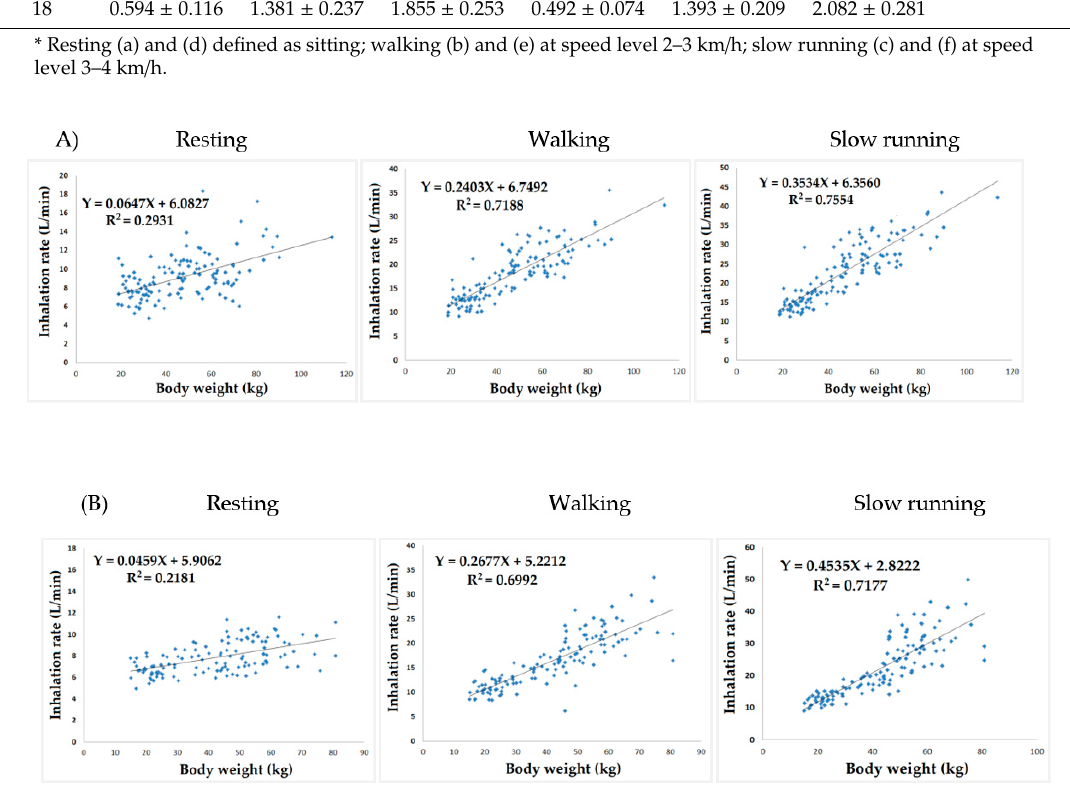
Figure 2. Estimated short-term inhalation rates for boys ( A ) and girls ( B ) aged below 4 years using the correlation between inhalation rate and body weight of children aged 5–18 years. Table 4. Recommended values for inhalation rate according to age group.